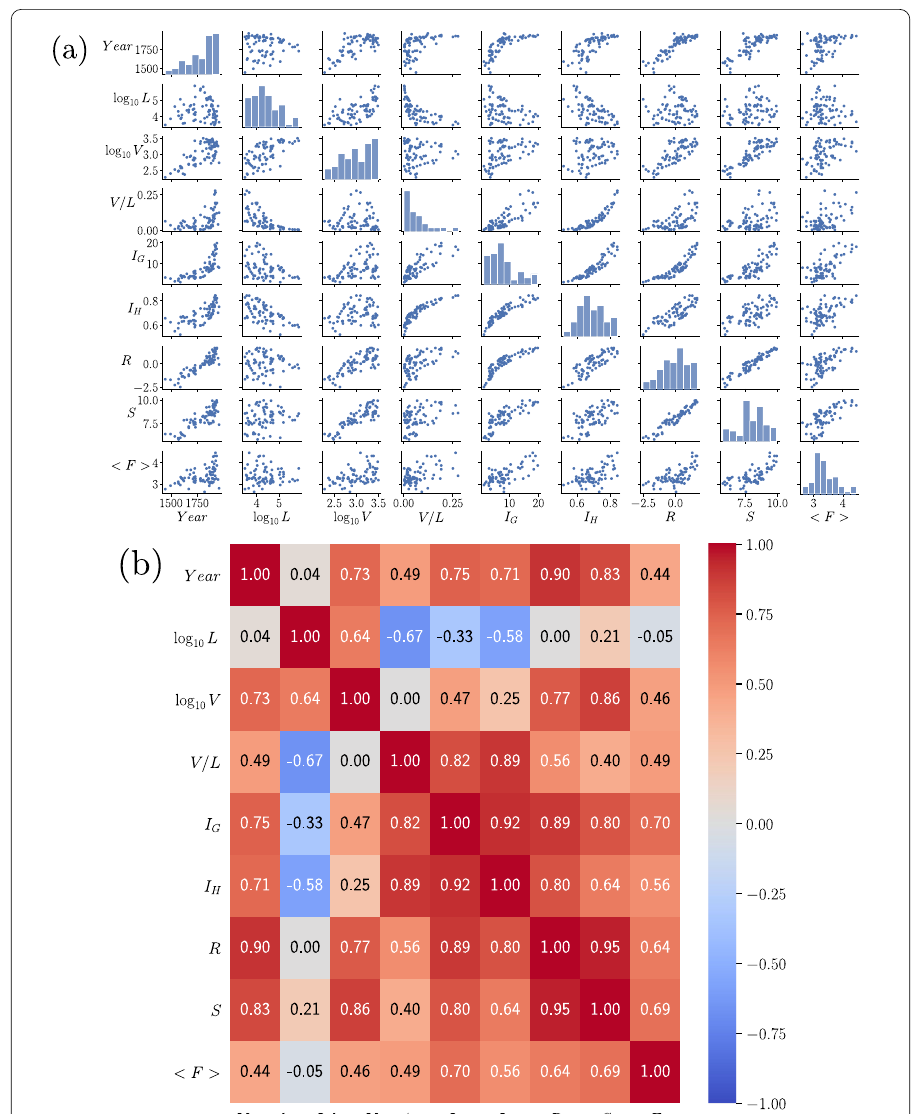
Figure 5 Comparison of the different metrics characterizing each composer. ( a ) Scatter plots. ( b ) Matrix of linear correlation coefficients